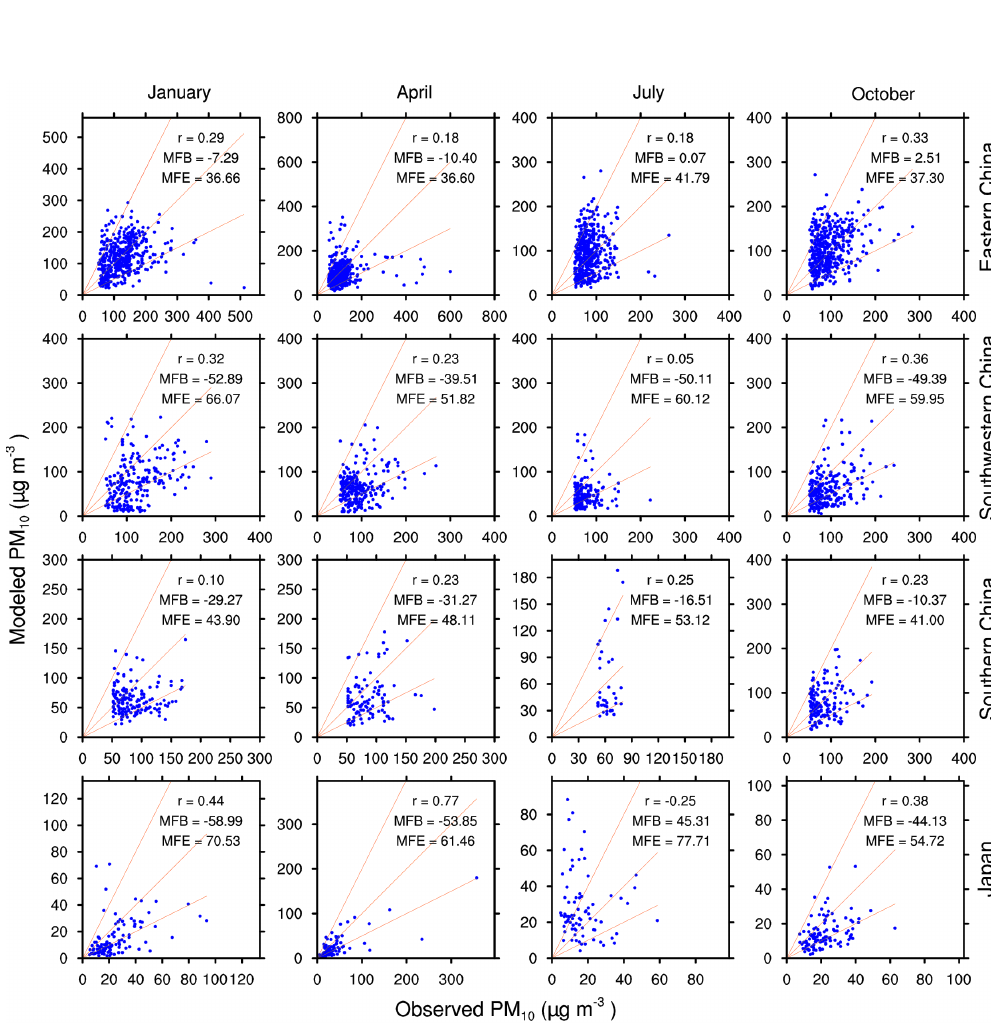
Figure 6. Comparisons of simulated and observed daily mean PM 10 (µgm − 3 ) in eastern, southwestern, and southern China, and Japan in each month. The model to observation ratios of 2:1, 1:1, and 1:2 are represented by orange lines. Monthly average performance statistics ( r , MFB, and MFE) are